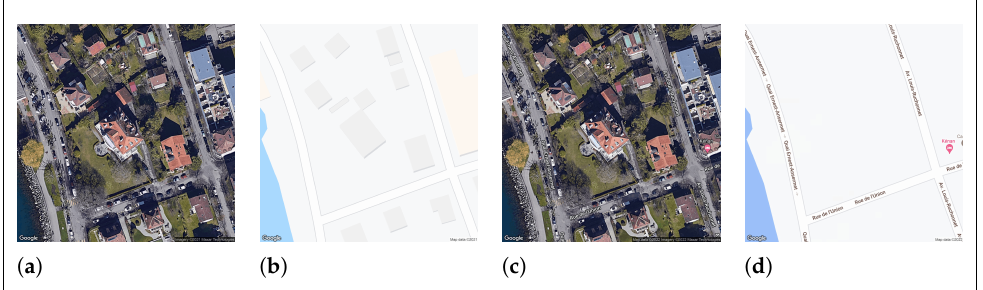
Figure 4. Example of four Google Static Map images for a given listing: satellite ( a ), roadmap ( b ), hybrid ( c ), and terrain ( d